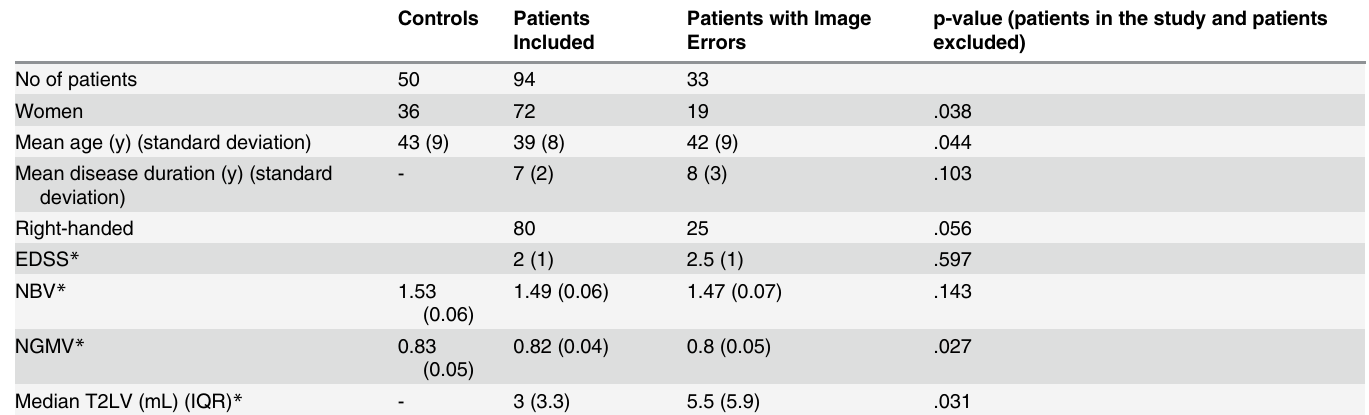
Table 1. Clinical and radiological characteristics of all patients ’ groups in this study.